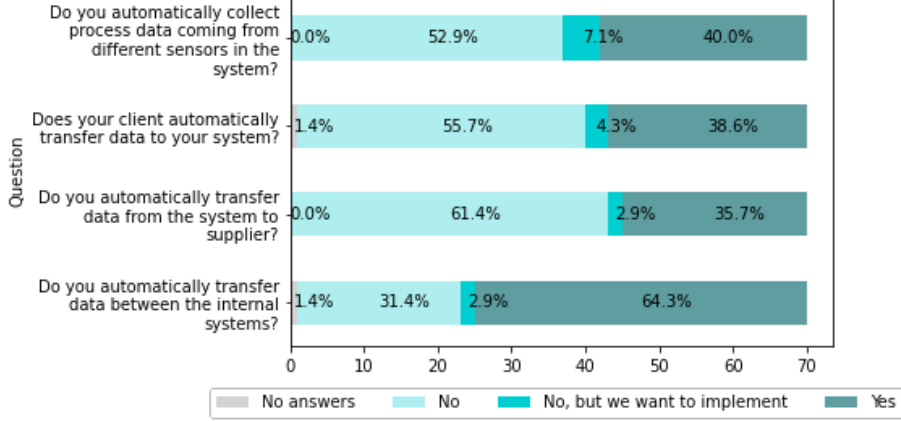
Figure 14. The functionalities of the systems related to the data transfer automatization imple- mented in the companies — number of questionnaires and percentage of answers in the total number of 70 questionnaires.